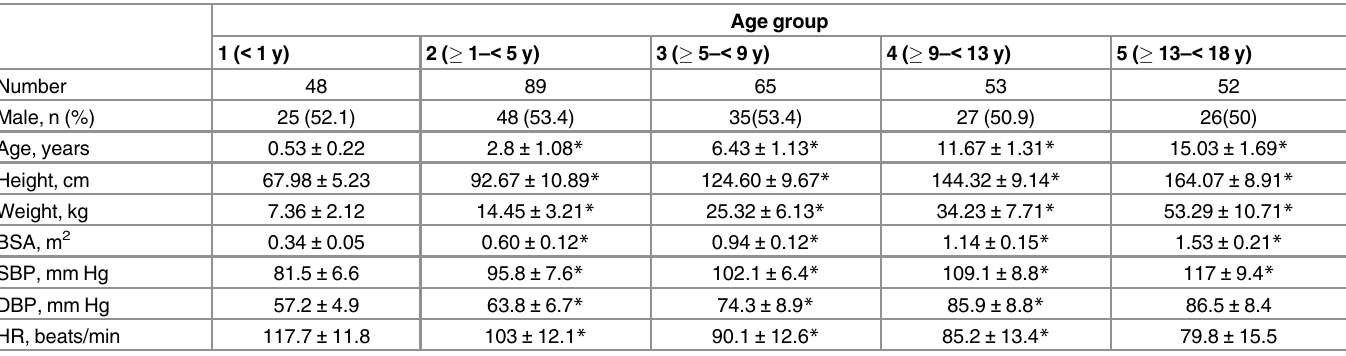
Table 1. Demographic and anthropometric characteristics.